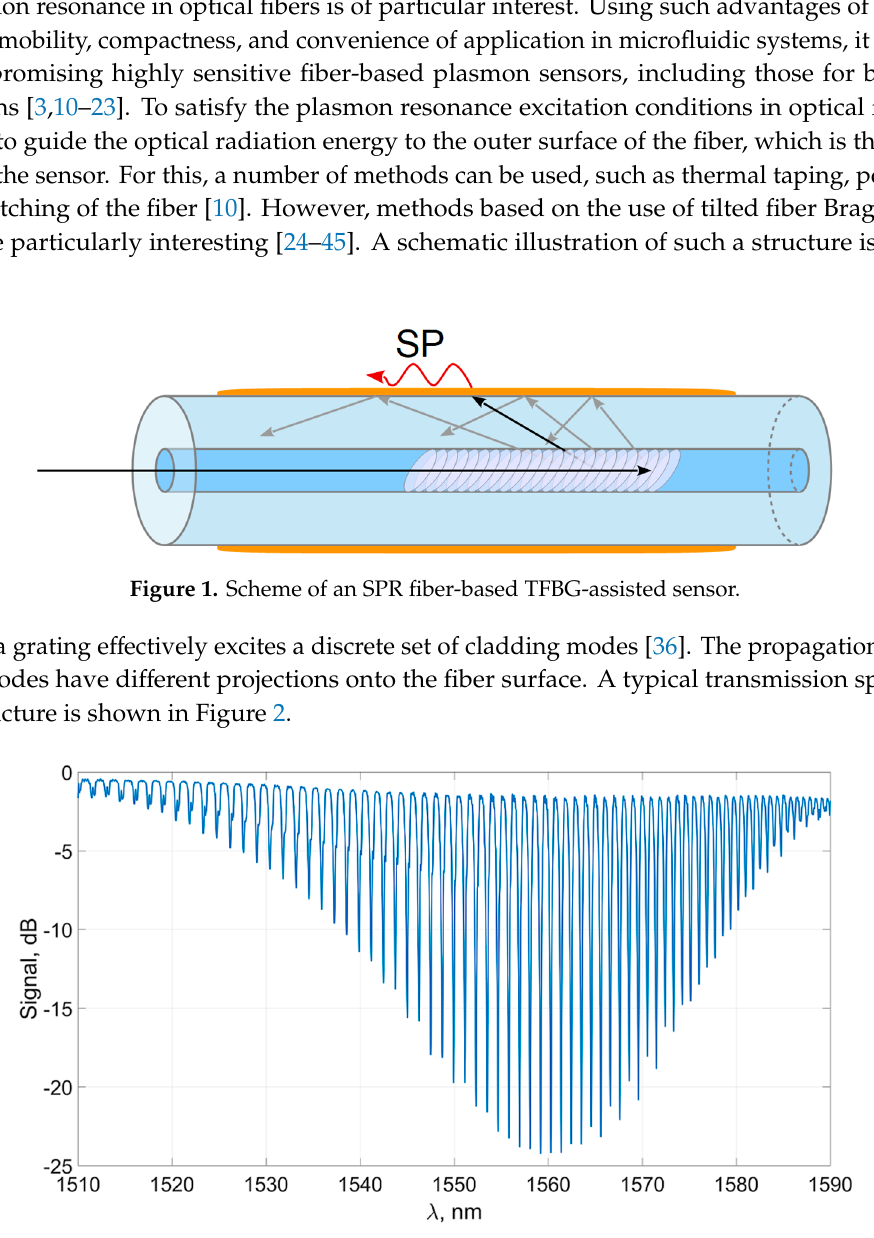
Figure 2. TFBG transmission spectrum.